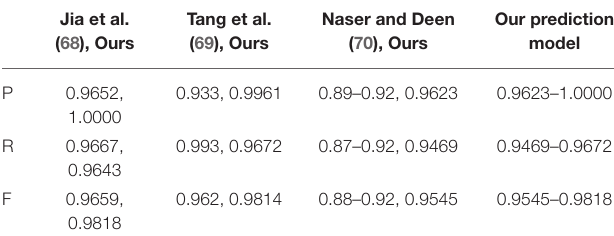
TABLE 11 | The evaluated segmentation results of patient images. Jia et al. (68),